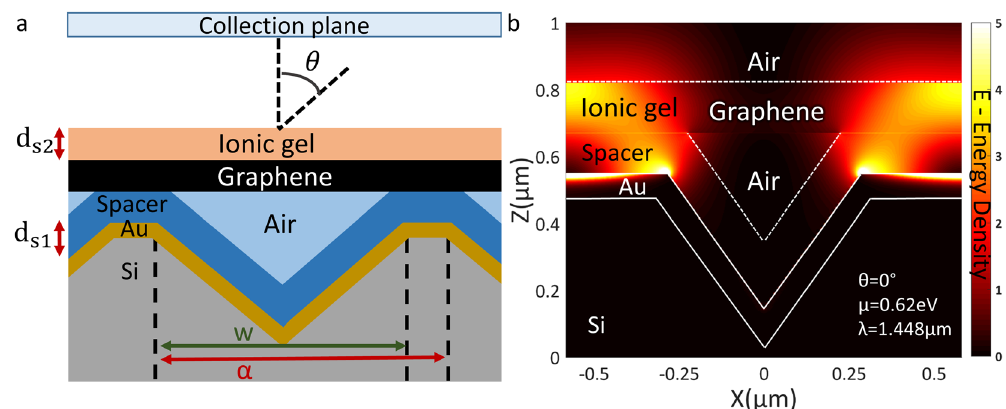
Figure 3. ( a ) Schematic setup and ( b ) E field density plot for the hybrid gold-insulator-graphene plasmonic